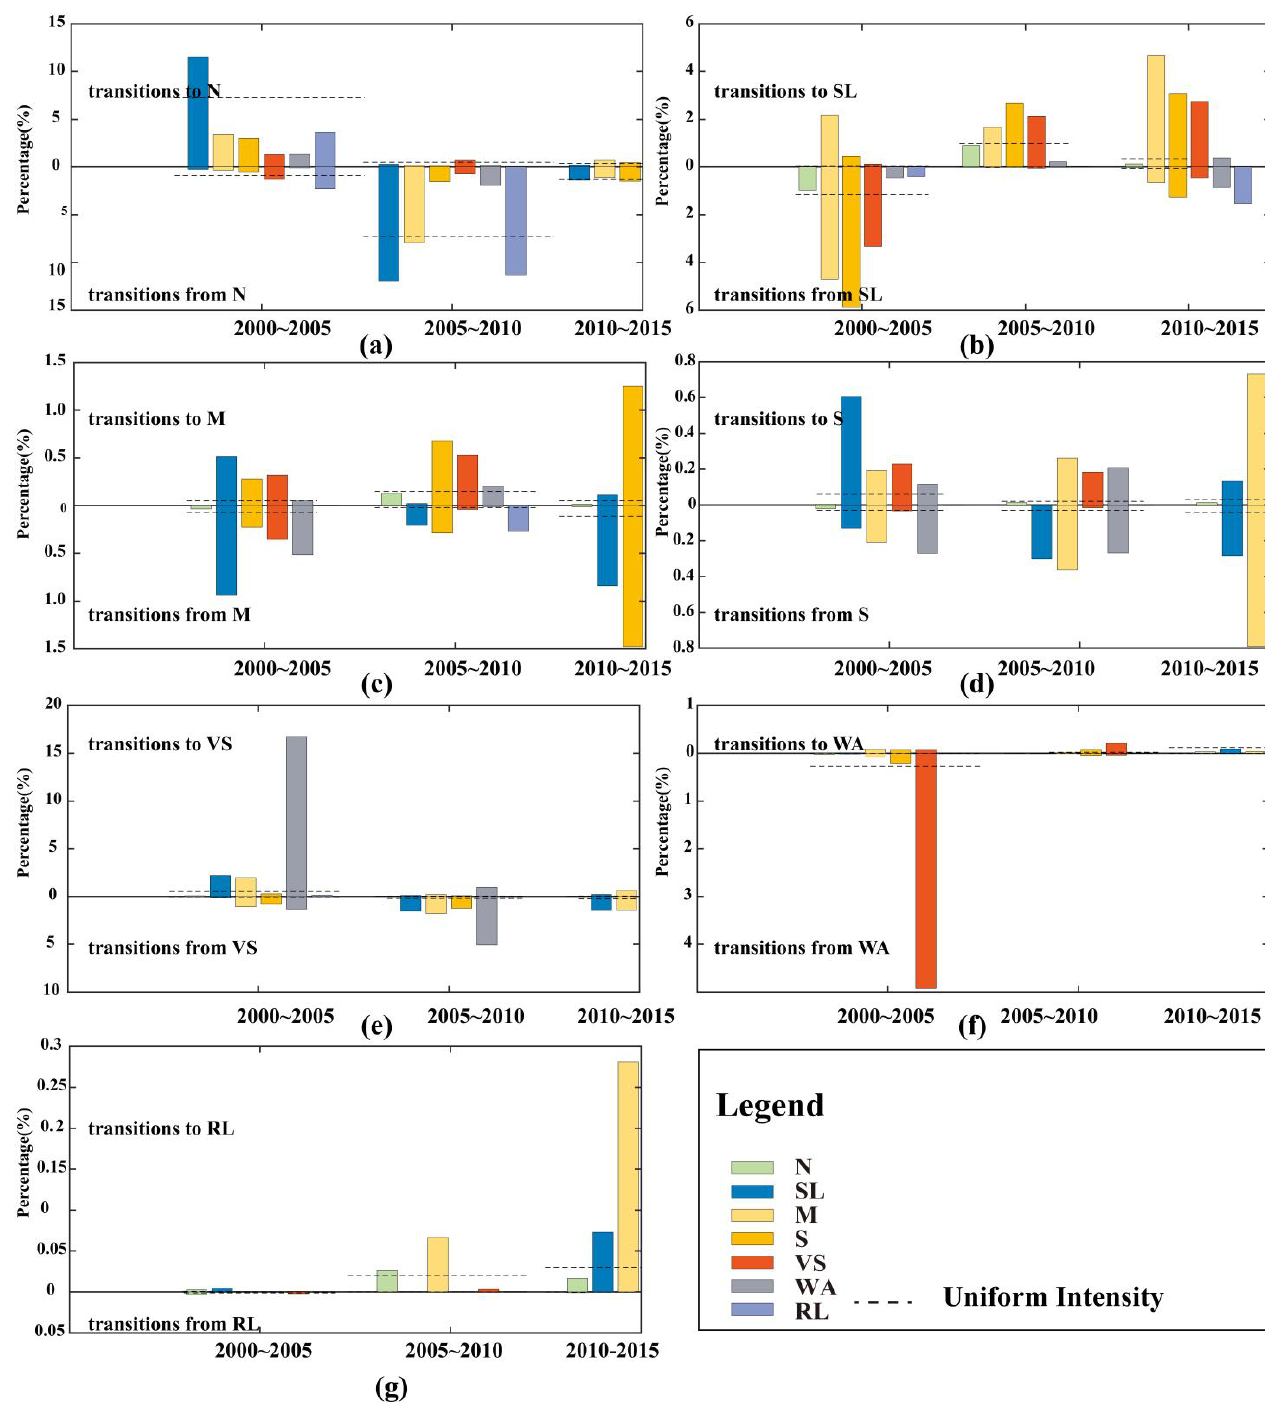
Figure 7. Transition area and intensity changes for different types of land in the East Ujimqin Banner .